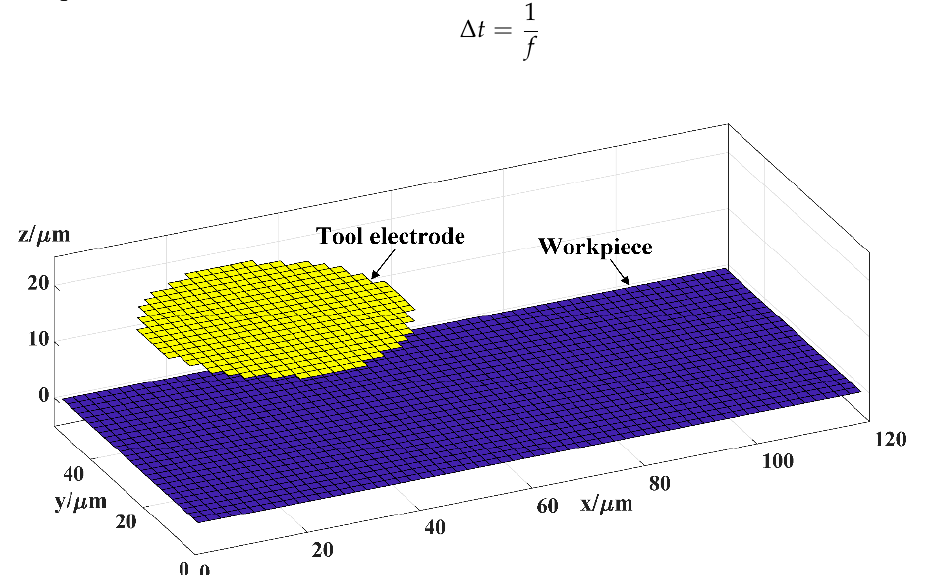
Figure 6. Meshing of the tool electrode and the workpiece.